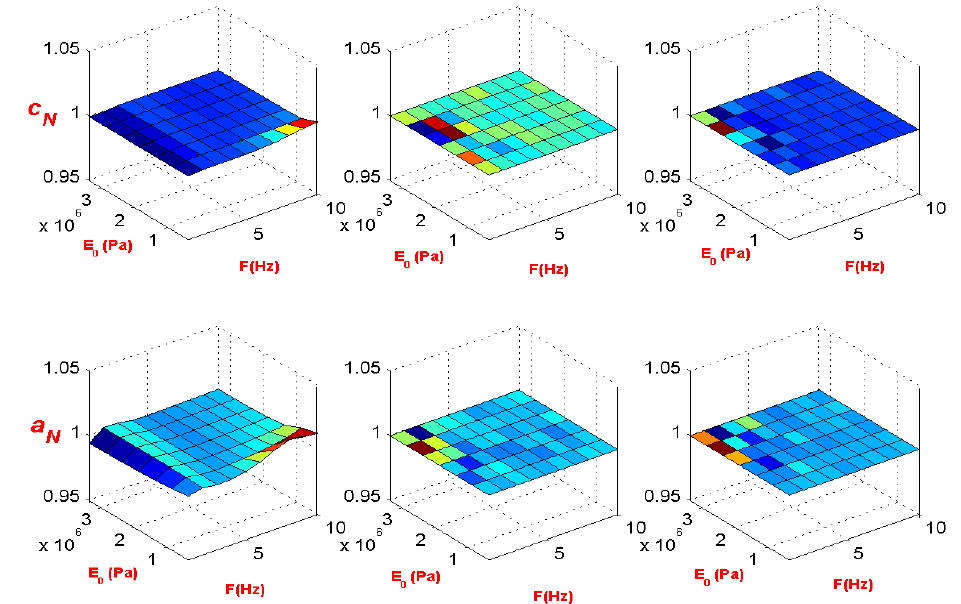
Fig. 3 Three dimensional view (see legend Fig.2) of frequency pattern of normalized phase velocity and normalized attenuation for various wall stiffness ( E 0 =0.36, 0.86, 1.36, 1.85, 2.35, 2.85, 3.35 x10 6 Pa